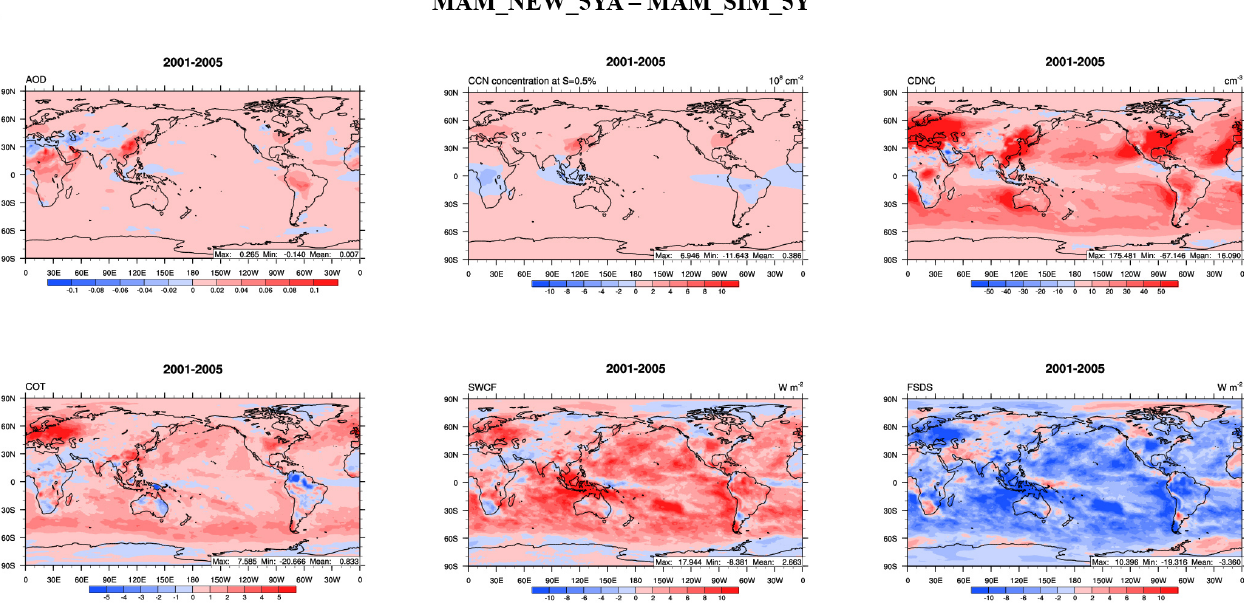
www.atmos-chem-phys.net/14/9171/2014/ Atmos. Chem. Phys., 14, 9171–9200,